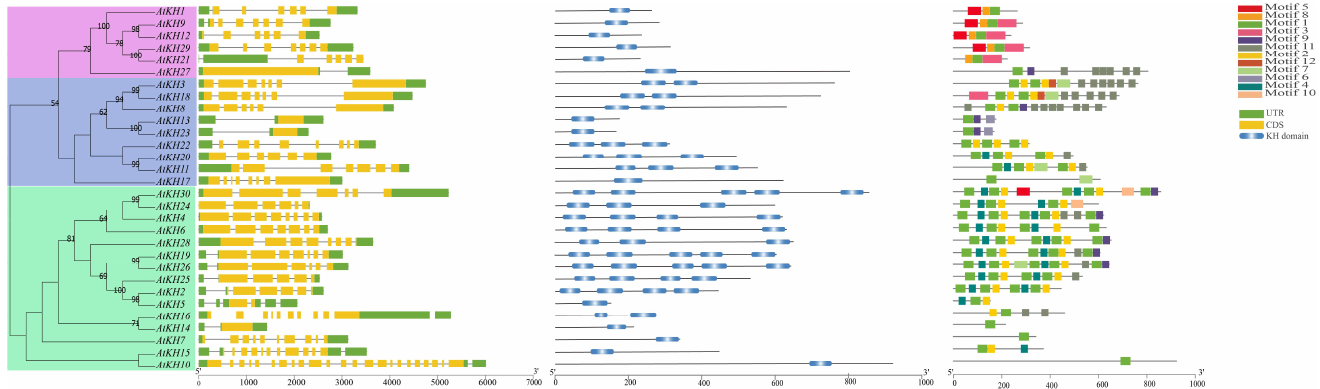
Figure 1. The phylogenetic tree, gene structure, KH domain location, and position of conservative motifs of 30 Arabidopsis thaliana KH family genes. From left to right were the unrooted phylogenetic tree, gene structure, position of KH domain and position of conservative motif. The axis below indicated the length of the CDS and protein.